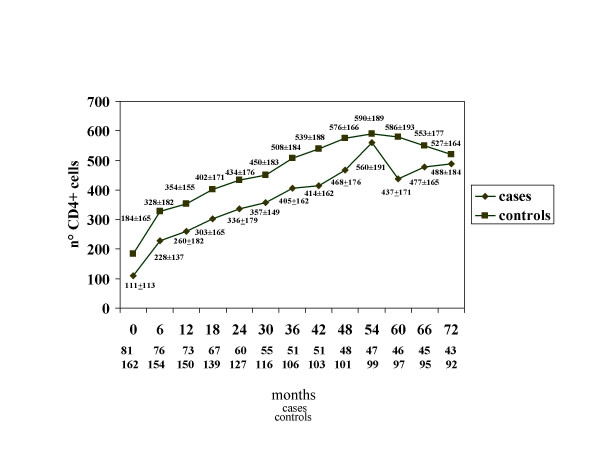
T CD4+ cell count/mm3 (mean ± SD) at the beginning of HAART and each six months of follow-up in cases and controls.